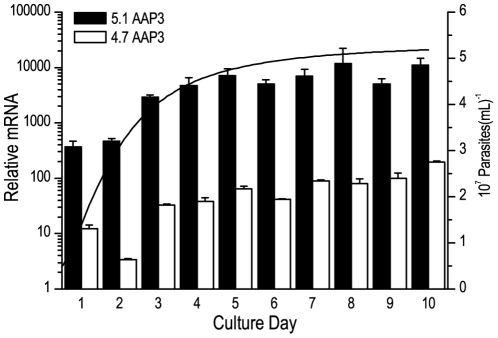
mRNA quantification from the parasite culture-growth curve.Total RNA from each day on the culture growth curve was used to obtain the cDNA. mRNA of both arginine transporters in L. (L.) amazonensis were determined (5.1 AAP3 mRNA in black; 4.7 AAP3 mRNA in white), and both were normalized to GAPDH mRNA. The black line represents the parasites' growth curve. The results of a representative experiment. Data are shown as the mean±S.E. (n = 4).